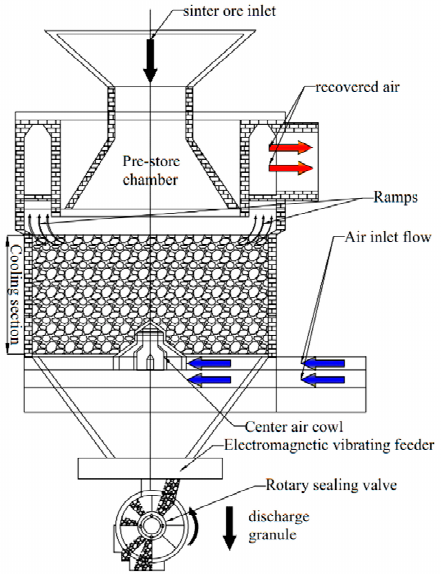
Figure 1. Schematic showing the operation of a vertical sinter cooling bed.